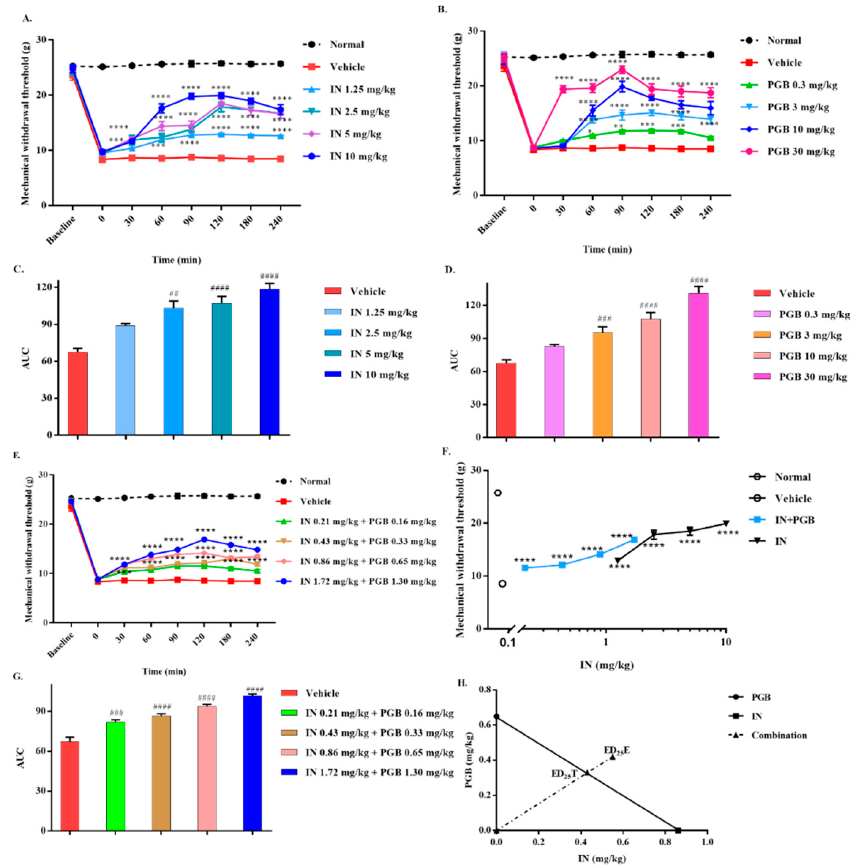
Figure 4. Effect of IN, PGB, and IN-PGB on carrageenan-induced mechanical allodynia. Time course effects on the MWT produced by administration of IN ( A ) or PGB ( B ) in rats. The AUC shows that an injection of IN, PGB, or IN-PGB reversed carrageenan-induced allodynia in a dose-related manner ( C , D ). Equieffective doses of IN and PGB were administered in combination to reverse mechanical allodynia ( E ). The combination of PGB and IN made the dose–response curve move to the left ( F ). Time course effects of IN-PGB are expressed as the AUC ( G ). Isobolographic analysis indicated an antagonis- tic/subadditive interaction between IN and PGB on carrageenan-induced mechanical allodynia ( H ). * p < 0.05, ** p < 0.01, *** p < 0.001, and **** p < 0.0001 versus vehicle by two-way ANOVA followed by Dunnett’s test. Data are expressed as mean ± S.E.M., n = 6